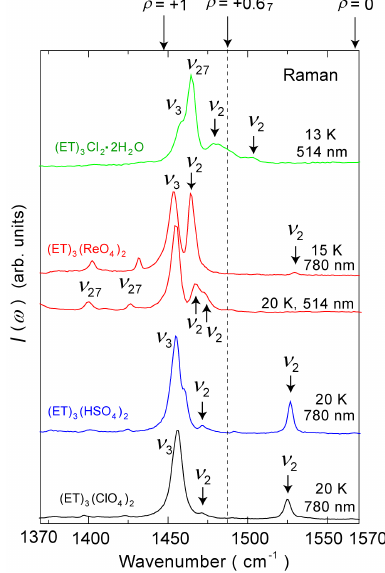
Figure 9. Raman spectra of some 2/3-filled salts at low temperatures. The ν salt exhibits peak separation. The frequencies at ρ = 0 and +1 are denoted by the arrows on the top of the panel. The frequency corresponding to +0.6 dotted line in this